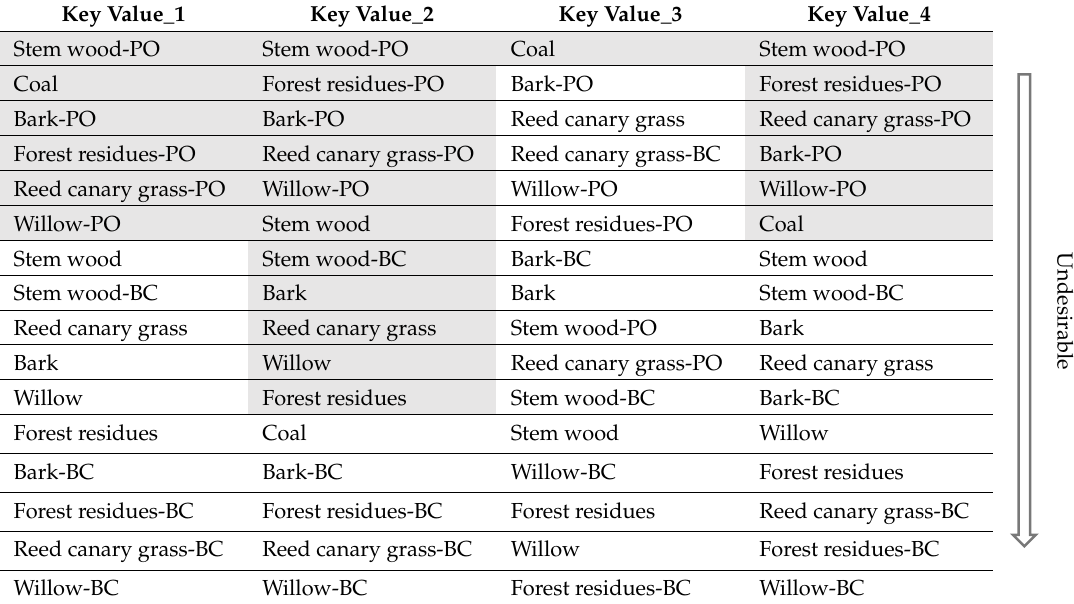
Table 2. Comparison of the investigated fuels according to the defined key values. Key values_1–4 refer to: slagging at the transfer-chute, slagging in the rotary kiln, strength of the resulting deposits, and submicron particles (mg / MJ), respectively. PO and BC stand for pyrolysis oil and biochar.